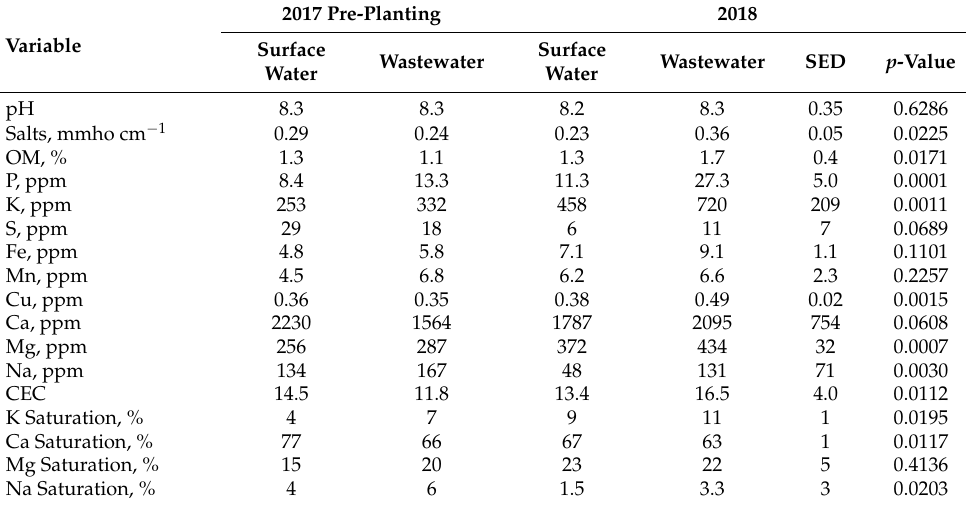
Table 3. Pre-planting soil analysis of irrigation water source strip plots (surface water or Class 1B, UV-irradiated treated municipal wastewater) in 2017 and results of by-plot sampling in 2018 one year after alfalfa establishment at Tucumcari, NM, USA. Soil testing in 2017 was not replicated and thus no statistical analysis was possible. Values for 2018 are the means of four replicates within each water source strip plot.